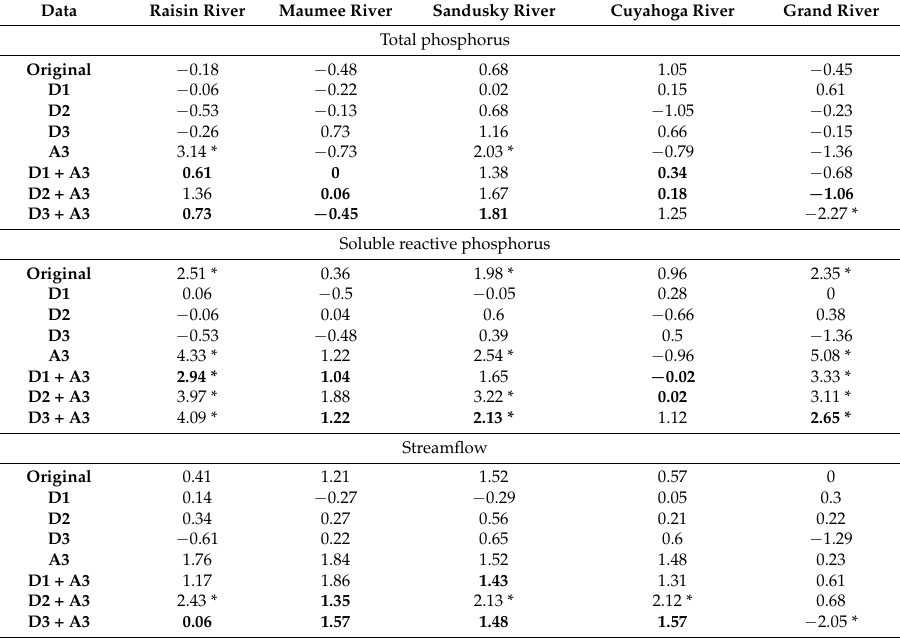
Table 2. The Mann–Kendall values of the original and DWT annual data of the total phosphorus, streamflow, and soluble reactive phosphorus. Each DWT is composed of the D (details) components (D1–D3), the approximation (A3), and a set of combinations of the Ds and their respective A3. The most effective periodic components for trends are indicated in